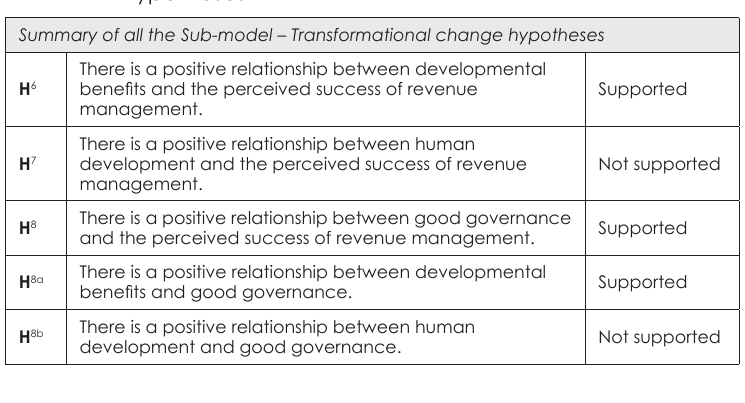
Summary of all the Sub-model – Transformational change